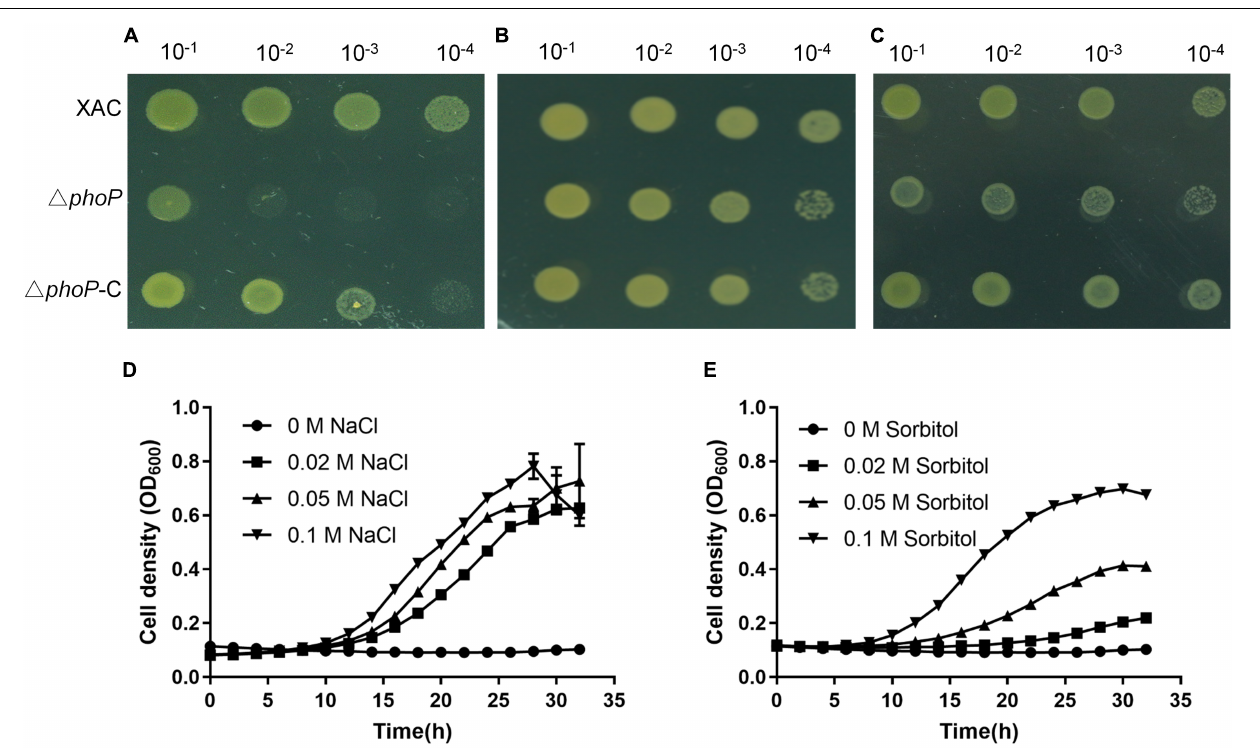
FIGURE 2 | Enhanced growth of phoP mutant under low osmostress. (A) Growth of bacterial strains on rich NYG medium plates. (B) Growth of bacterial strains on rich NYG medium plates supplemented with 0.05 M NaCl. (C) Growth of bacterial strains on rich NYG medium plates supplemented with 0.05 M sorbitol. (D) Growth curves of phoP mutant strain in rich NYG medium supplemented with 0 M NaCl, 0.02 M NaCl, 0.05 M NaCl, or 0.1 M NaCl, respectively. (E) Growth curves of phoP mutant strain in rich NYG medium supplemented with 0 M sorbitol, 0.02 M sorbitol, 0.05 M sorbitol, or 0.1 M sorbitol, respectively. OD 600 of cultures was monitored using a Bioscreen-C Automated Growth Curves Analysis System (Oy Growth Curves FP-1100-C, Helsinki, Finland). Error bars, mean ± standard deviation ( n = 3). All experiments were repeated three times with similar